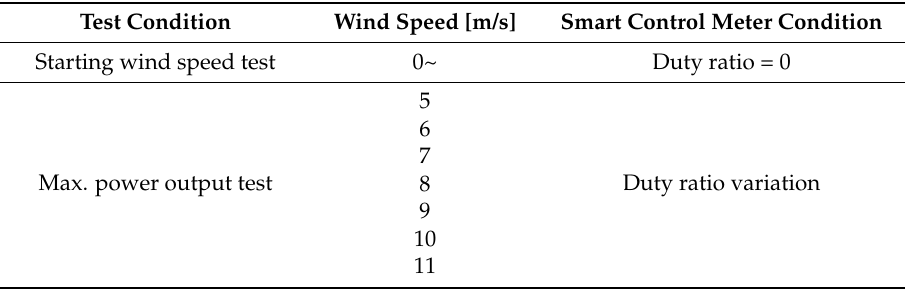
Table 5. Scenario for wind tunnel test.